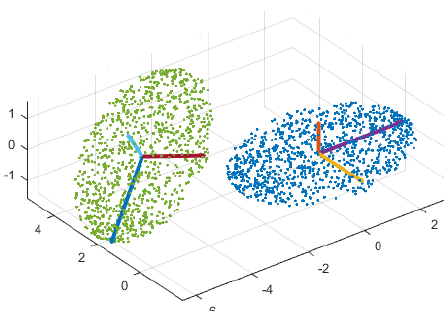
Figure 7. Right-hand rule inspection of two embedded manifolds. The first three principal directions of the reference (blue) and the sensed manifolds (green) follow the left-hand and the right-hand rule,